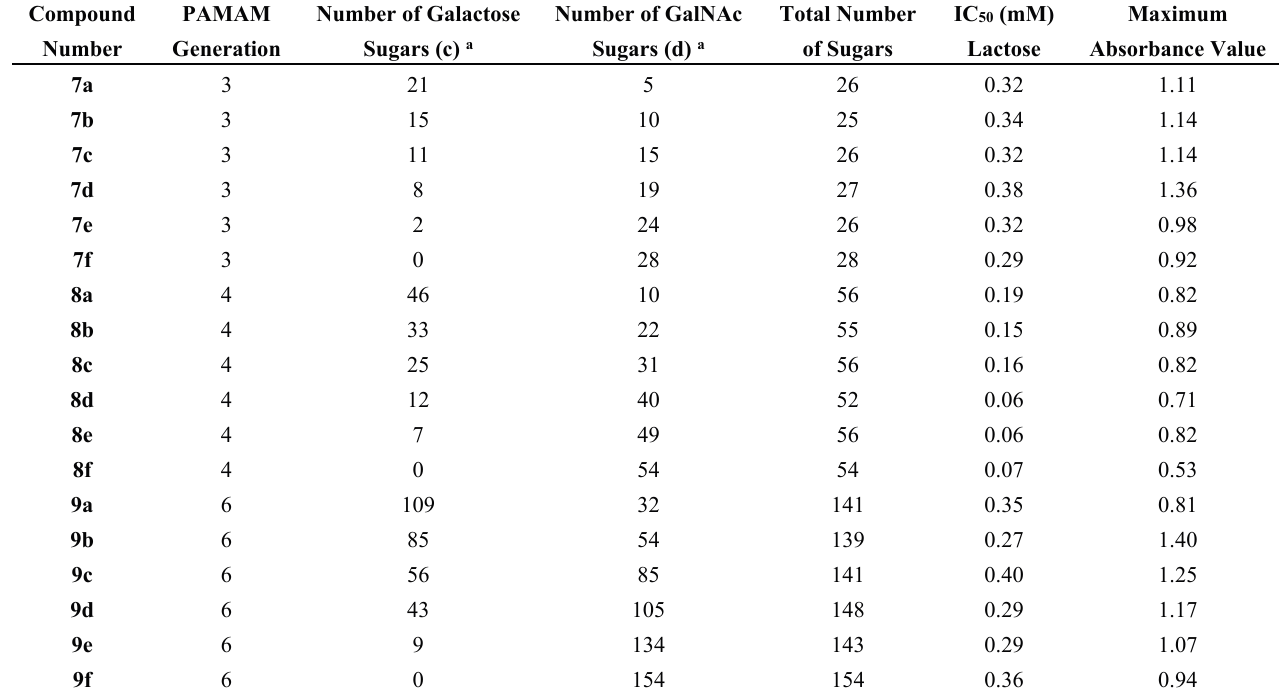
Table 2. Results for Compounds 7a – f , 8a – f and 9a – f with